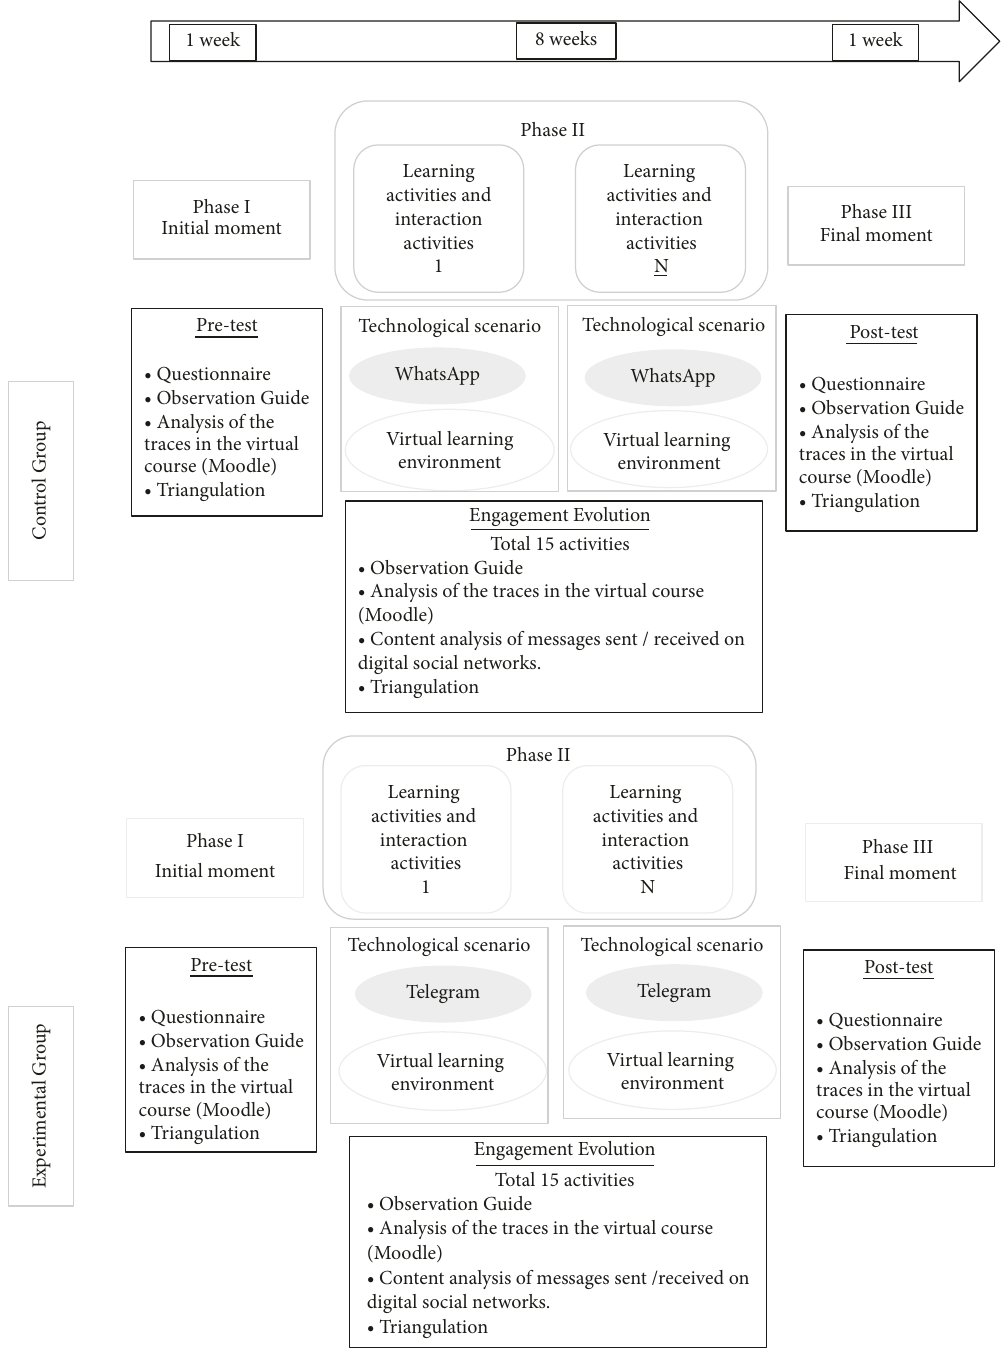
Figure 2: Overview of study